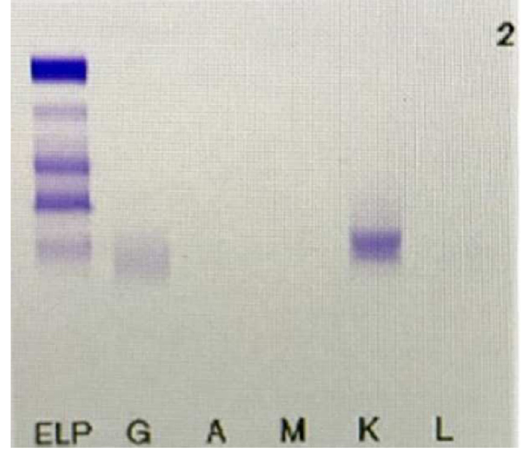
Figure 1: Serum immobilized electrophoresis ( IFE ) revealed positive result for κ - light chains.